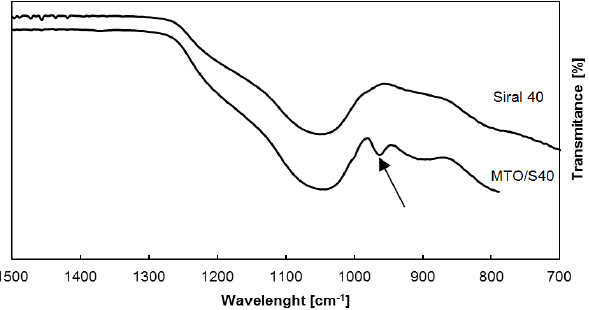
Figure 5. Fourier transform infrared spectroscopy (FTIR) spectrum of Siral 40 and its MTO modified form (15 mg MTO/100 mg Siral